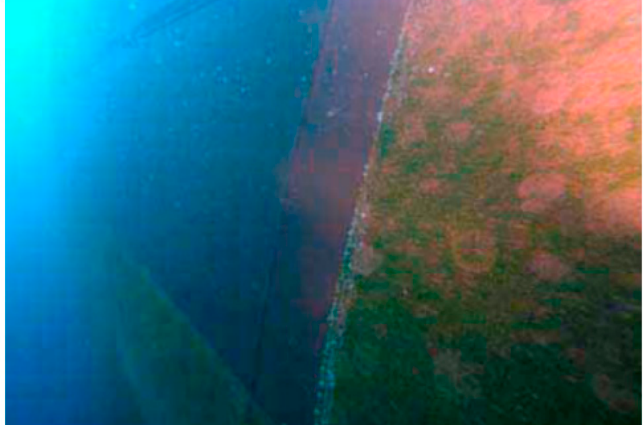
Figure 13. Ship’s hull showing a patch covered with silicon hydrogel (right side), whereas slime and algae are found on the hull with SPC coating paint (left side). Reprinted from [120] with the permission of the American Chemical Society, copyright